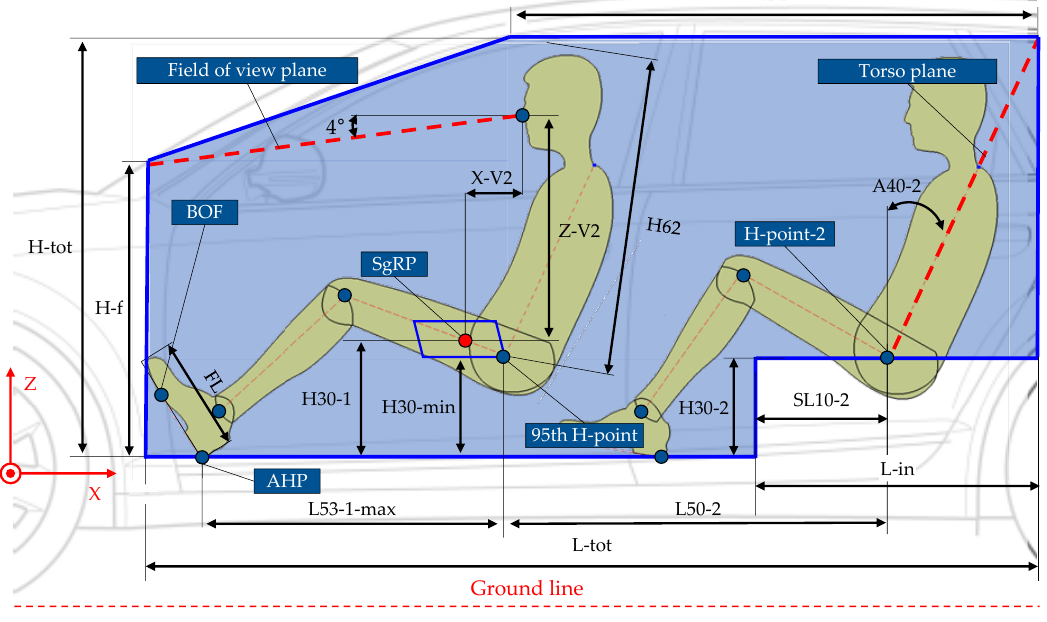
Figure 7. Definition of the passenger compartment volume [26]